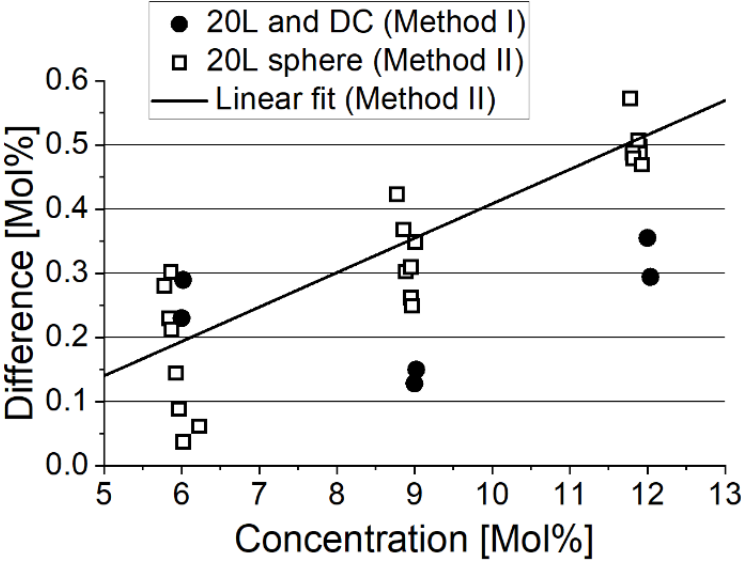
Figure 4. Difference between the calculated amount and the direct measured amount of gas against the calculated concentration. the calculated